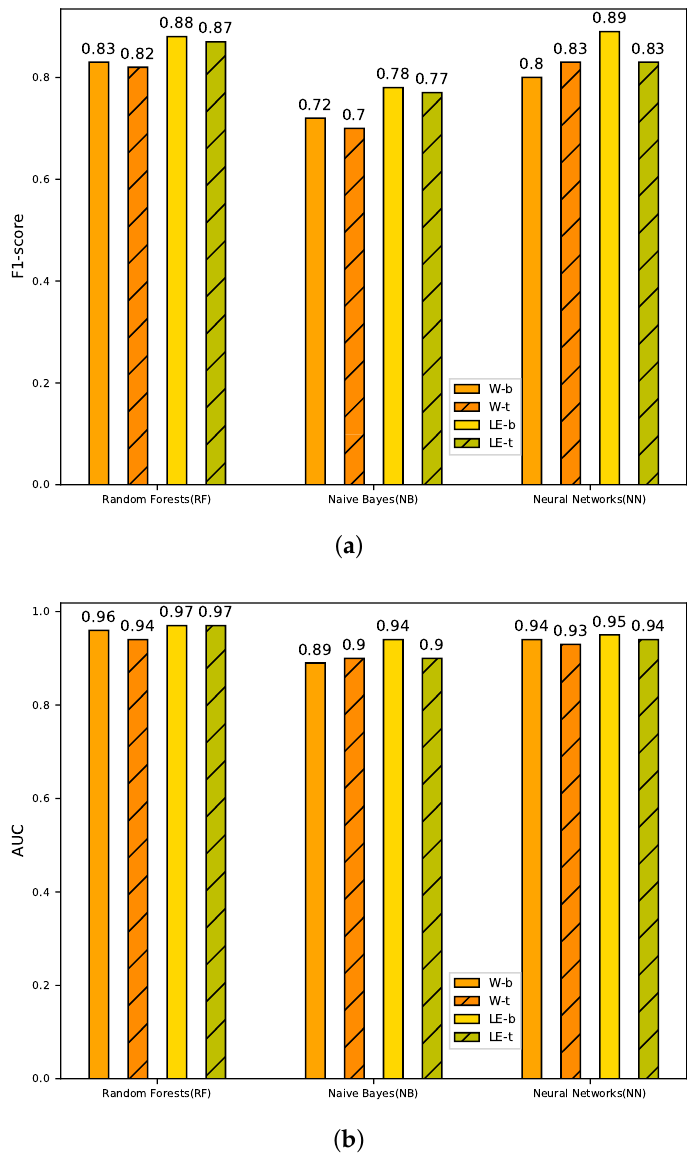
Figure 4. Performance of different schemes with bary and tf-idf coordinate transformations. ( a ) F1-score; ( b )